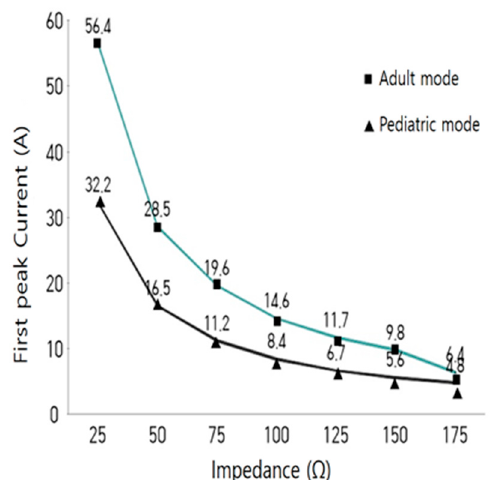
Figure 5. Relationship between impedance and peak current in adult mode and pediatric mode, respectively.